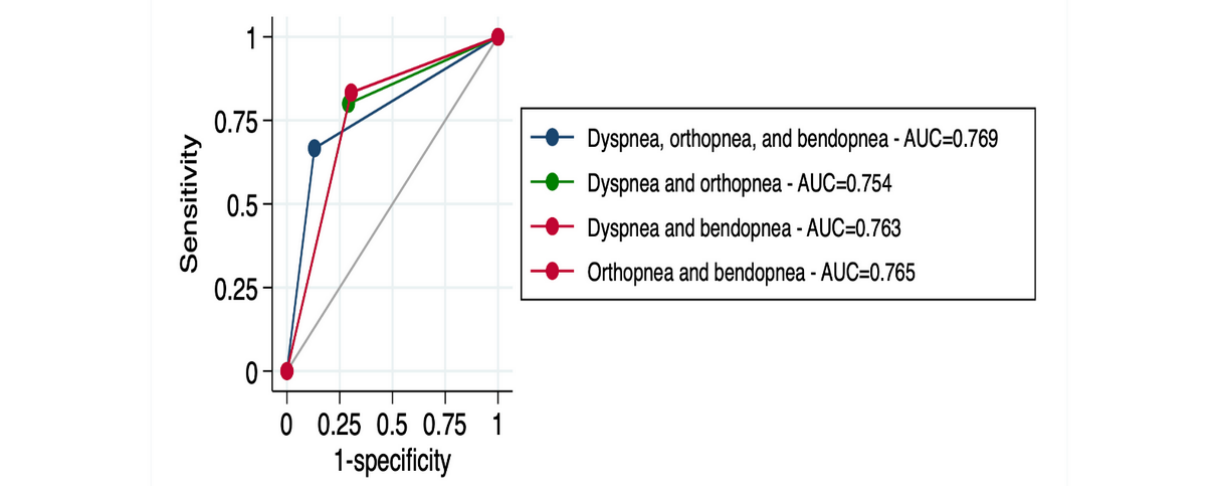
Figure 2. Areas under the curve for subjective respiratory symptoms. AUC: area under the